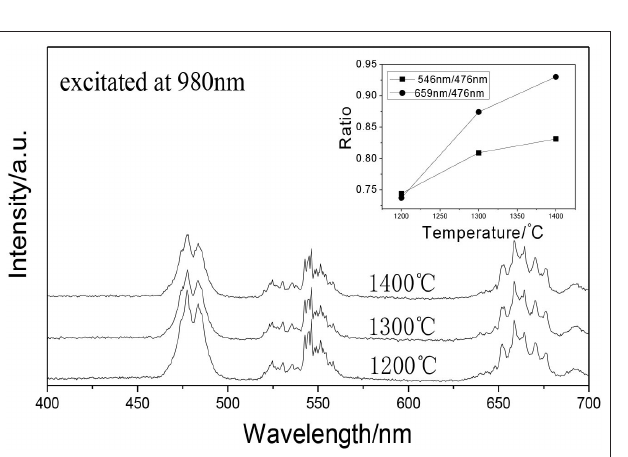
FIGURE 6 | UCPL spectra of the GdAlO 3 : 0.6%Er 3 + , 16%Yb 3 + , 1%Tm 3 + phosphors prepared by calcining the precipitate at different temperatures (inset is the dependence of the 546 nm/476nm and 659 nm/476nm intensity ratio on calcination temperature).